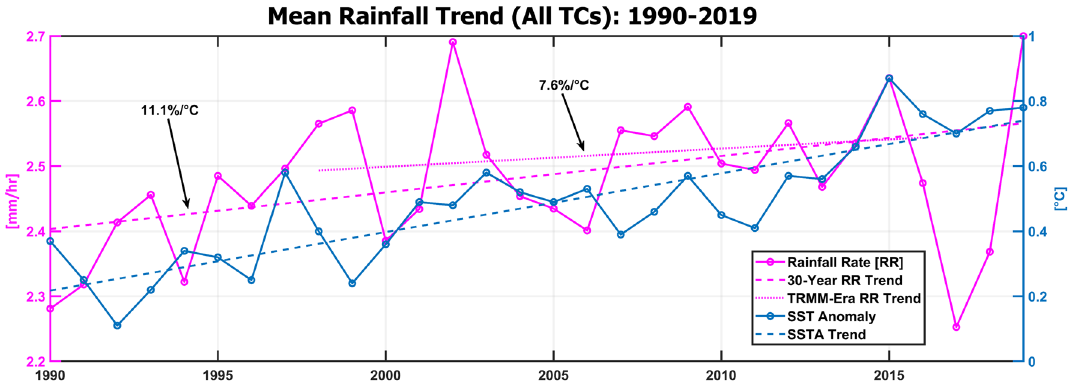
Figure 6. Mean precipitation rate values from All TCs (no smoothing) measured by PDIR-CDR during the 1990–2019 period (magenta) compared to sea surface temperature anomaly measurements (blue) from NOAA NCEI’s Climate at a Glance data portal 58 . Two trends are analyzed: 30-year (1990–2019) and TRMM-era (1998–2016), which show an increase in precipitation rates of 11.1%/C and 7.6%/C,